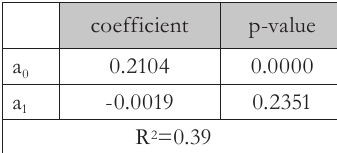
Tab. 2 – OLS estimation of sigma-convergence equation for 27 European Union